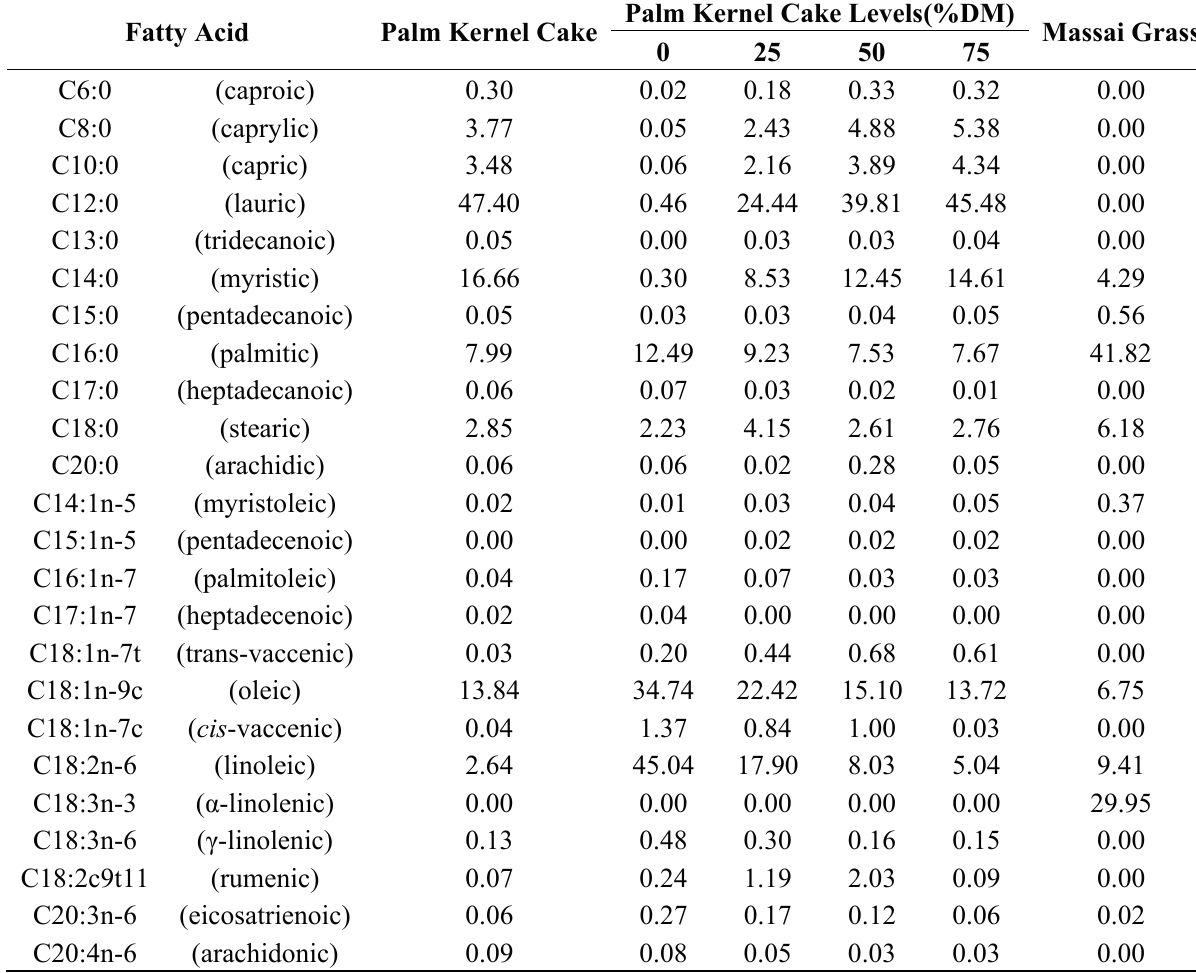
Table 6. Fatty acid compositions of the palm kernel cake, concentrate supplements, and Massai grass when expressed as a percentage of the total fatty acids. Fatty Acid Palm Kernel Cake